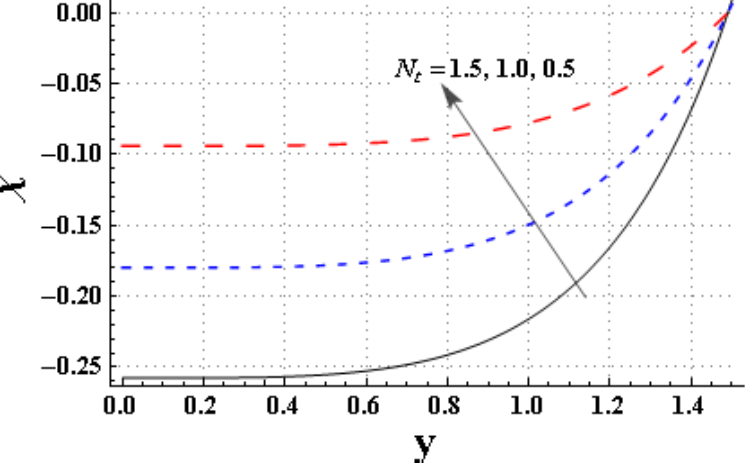
. . G . , on the concentration of motile mi- G , on the concentration of motile mi- G , on the concentration of motile mi-